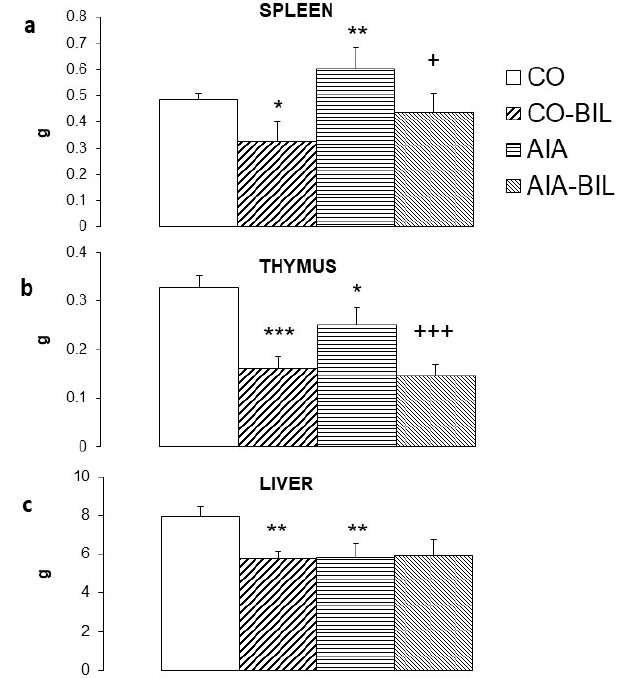
Figure 3. Weight of selected organs at the end of the experiment; ( a ). spleen, ( b ). thymus, ( c ). liver. CO—control group, CO ‐ BIL—control group administered with UCB 200 mg/kg of body weight daily i.p. from day 14, AIA—group with adjuvant induced arthritis, AIA ‐ BIL—group with adjuvant induced arthritis administered with UCB 200 mg/kg of body weight daily i.p. from day 14. Results are expressed as mean ± SEM, n = 7–8. Significant difference between groups CO and CO ‐ BIL, CO and AIA: *** p < 0.001 vs. CO, ** p < 0.01 vs. CO, * p < 0.05 vs. CO. Significant difference between groups AIA and AIA ‐ BIL: +++ p < 0.001 vs. AIA, + p < 0.05 vs. AIA.